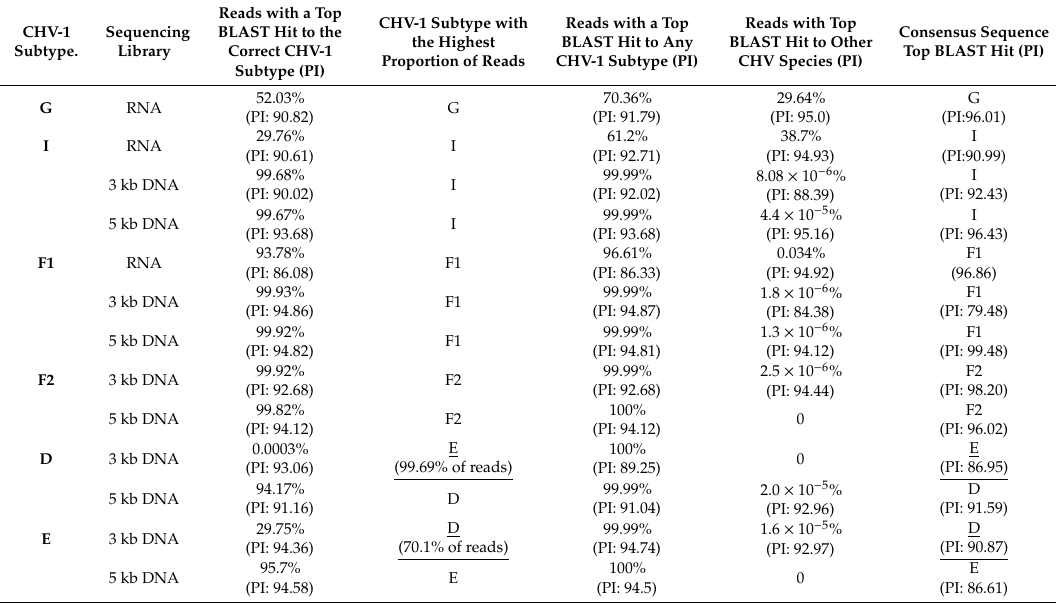
Table 2. BLAST analysis for raw sequencing reads. Shown are the number reads with the top BLAST hit to CHV-1 or other CHV species for each sequencing library. PI—mean percentage identity of the top hits. Underlined values denote an incorrect subtype assignment.